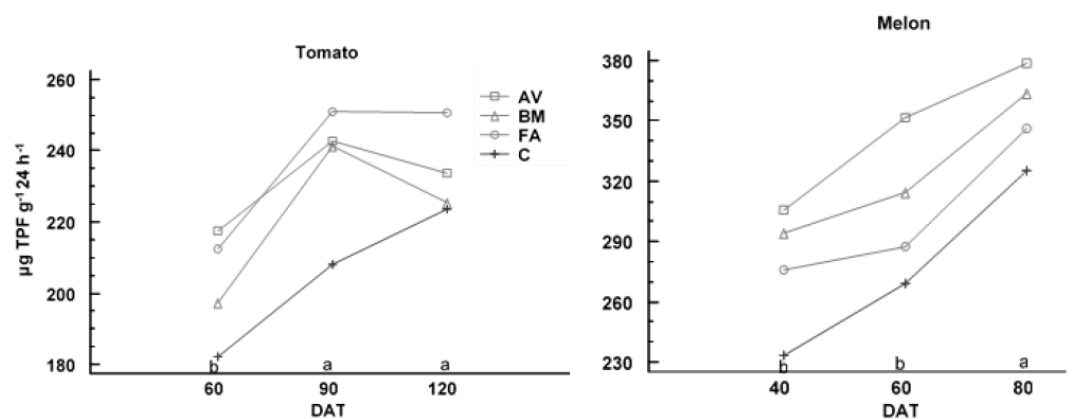
Figure 1. Evolution of dehydrogenase activity (DHA) activity during two growing cycles. AV, Azotobacter vinelandii ; BM, Bacillus megaterium ; FA, Frateuria aurantia ; C, Control; DAT, days after transplant.